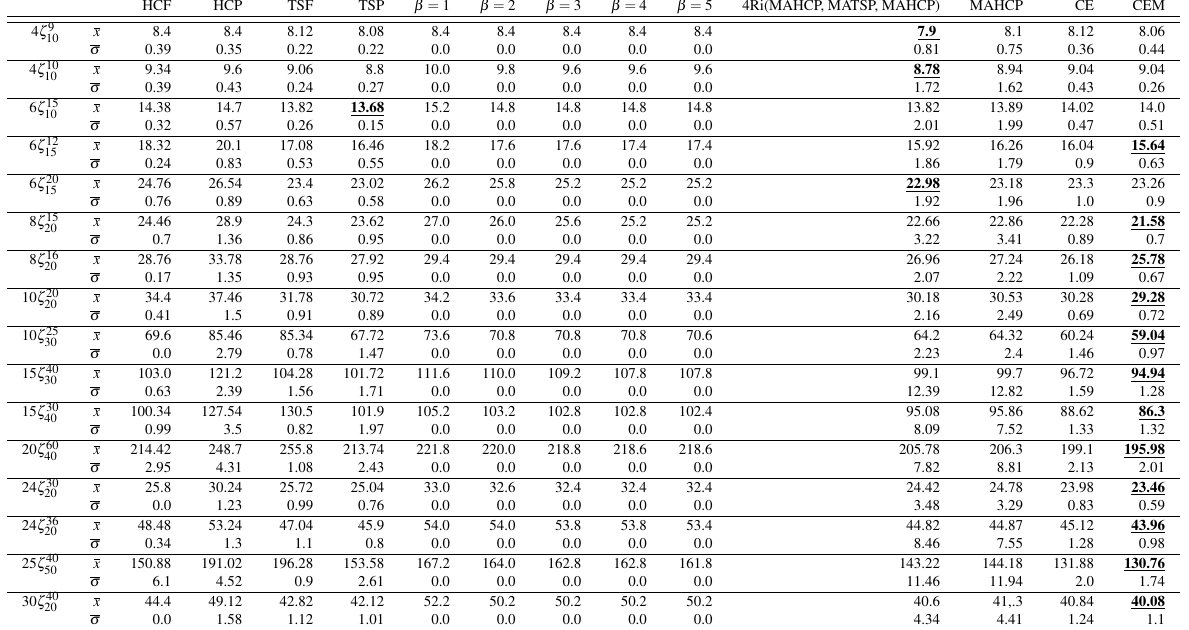
Table 6: Computational results with HC, TS, Beam Search —as proposed in 48 — for several values of the width beam (i.e., β ), memetic algortihms with HC, standard CE and CEM with 4 pmfs. x = mean number of tool switches. σ = mean standard deviation. Recall we are using the notation C ζ m m is the total number of tools and n is the number of